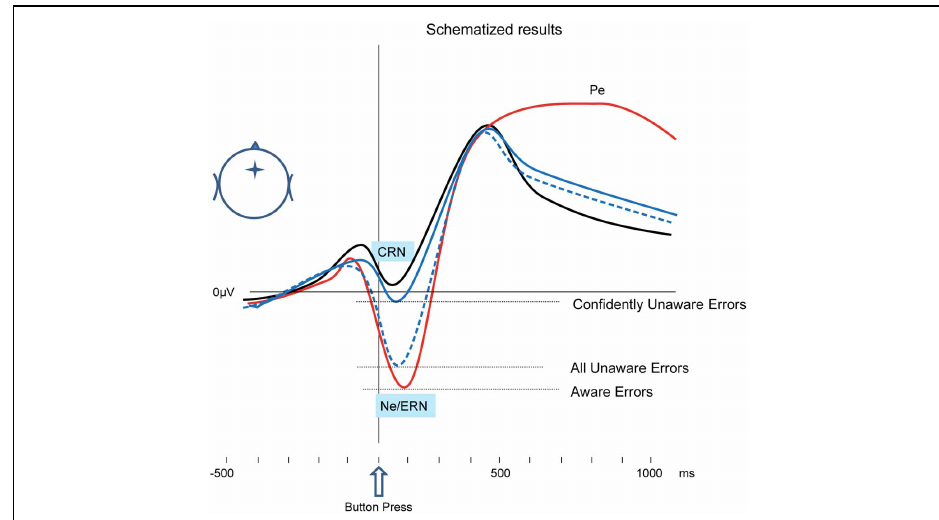
FIGURE 1 | Schematized results, based on Shalgi et al. (2009); Shalgi and Deouell (2012). In typical Ne studies, nominally Unaware Errors may elicit an Ne-like response (broken blue line), which is similar or a little smaller than the Ne elicited by Aware Errors (red line). However, when only errors which were confidently missed (a high bet on correct) are considered, the response to Unaware Errors is similar to the CRN elicited by correct responses (black